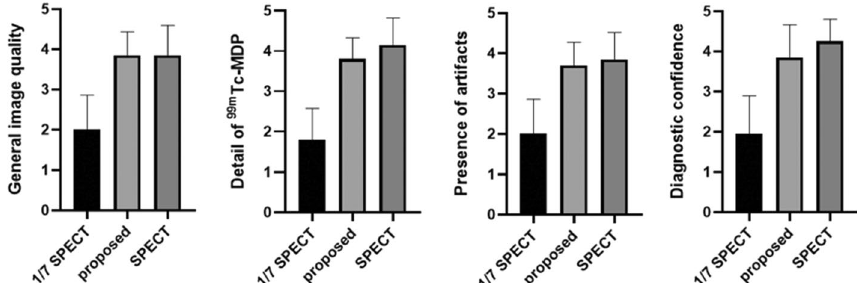
Fig. 5 An axial view of image difference between different methods and the standard SPECT. a – f The original image of 1/7 SPECT, EDSR, ESRGAN, RCAN, proposed method and the standard SPECT in the grayscale of minimum 0, maximum 120,000. g – k The difference between the standard and corresponding image = = (standard–corresponding image, minimum 20,000, maximum 20,000) = − =